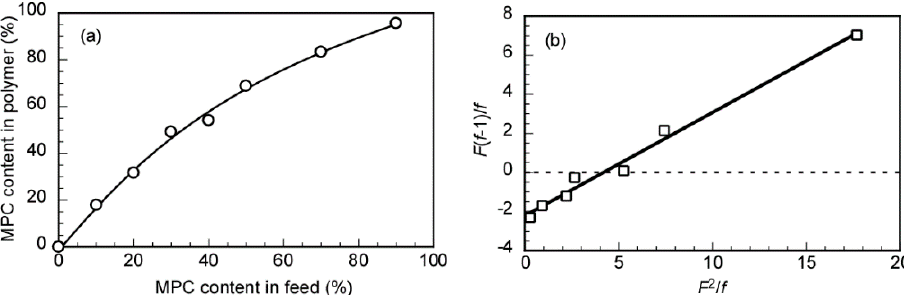
Figure 2. ( a ) Relationship between the 2-methacryloyloxyethyl phosphorylcholine (MPC) content in the copolymer and the feed. ( b ) The graphic representation of the Fineman–Ross equation, with F ( f -1) / f as a function of ( F 2 / f ).